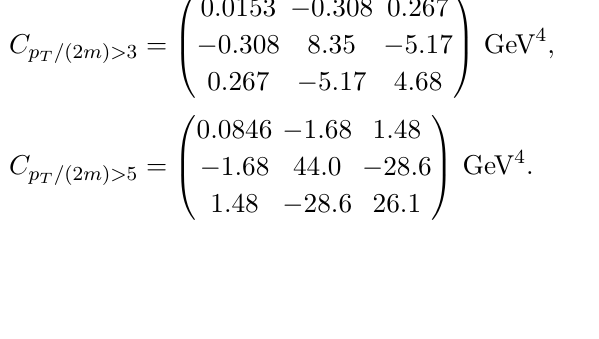
Table 1 . Fit results for the gluonic correlators E 10;10 , c 2 p T / (2 m ) > 3 and p T / (2 m ) > 5 . The B 00 and E 00 are renormalized in the MS scheme at the scale Λ = 1 . 5 GeV, and c F is computed at the heavy quark mass m = 1 . 5 GeV and at the MS scale Λ = 1 . 5